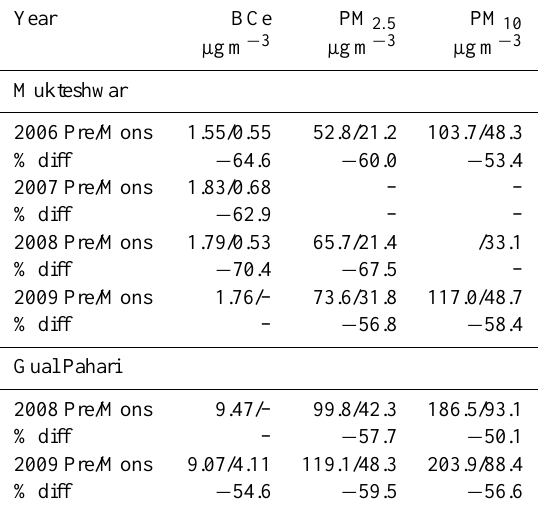
Table 2. Difference between the pre-monsoon and monsoon season aerosol concentrations in Mukteshwar and Gual Pahari. Concentra- tions are in STP